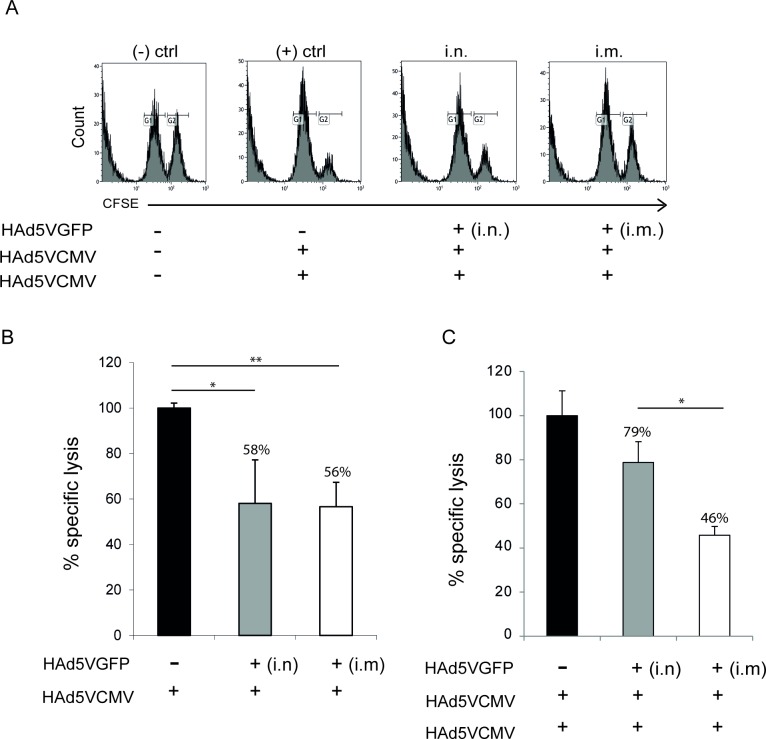

In vivo cytotoxicity levels against the murine CMV CD8 T-cell epitope YPHFMPTNL detected in animals with pre-existing HAd5V immunity or control animals after prime-boost immunization with HAd5V-based vaccine vector, HAd5VCMV.(A) Histograms show data from a single mouse and represent lowCFSE and highCFSE+CMVCD8-peptide labeled cells detected in spleens of HAd5VCMV-immunized BALB/c mice or control animals. (B) Percentage of specific lysis induced in vaccinated animals after a single immunization (prime) or (C) after completion of a prime/boost protocol. Pre-immunity was induced with 1×107 pfu/animal of Ad5GFP by the indicated route and vaccination was performed using one (prime) or two (prime/boost) doses (6 weeks apart) with 1×109 pfu/animal of HAd5VCMV administered subcutaneously. The graphs in panel (B) and (C) show one of three independent experiments with at least 4 mice per group. Bars represent mean values +/- SD. (+) ctrl–positive control; (-) ctrl–negative control; (-) mice non-immunized with adenovirus; i.n.–intranasal immunization route; i.m.–intramuscular immunization route.